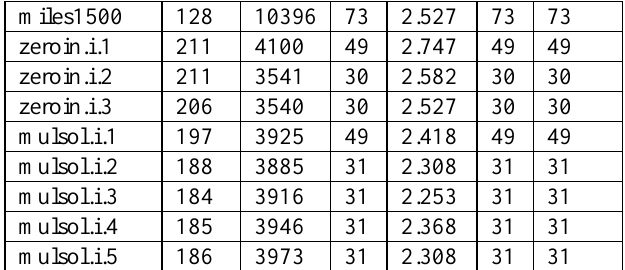
Table 7: Colouring results on the execution of proposed algorithms.